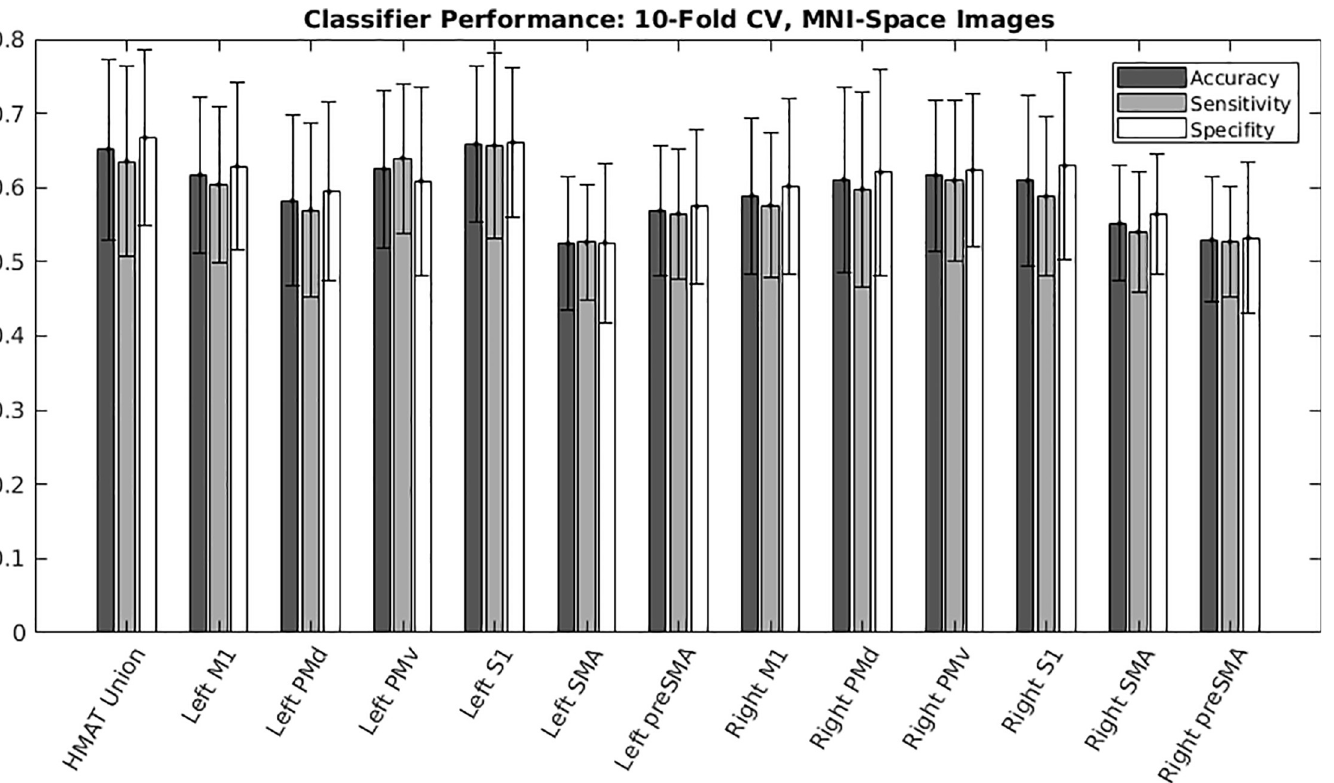
Fig 4. MNI-space images: Regional classifier performance in terms of accuracy, sensitivity, and specificity. We evaluated all regions incorporated by the Human Motor Area Template (HMAT). ROI’s for both hemispheres included the following: Primary motor area (M1), primary somatosensory area (S1), dorsal premotor cortex (PMd), ventral premotor cortex (PMv), supplementary motor area (SMA) and pre-supplementary motor area (pre-SMA). An additional ROI was the union of all HMAT masks into a single large mask (union HMAT). Table 2. Report of the top 3 regional accuracies within the Human Motor Area Template (HMAT), as well as from a union of all HMAT regions, for an SVM trained to differentiate wrist extension and flexion using spatially normalized images (realigned, slice-time corrected, and transformed to MNI coordinates) evaluated using 10-fold cross validation.